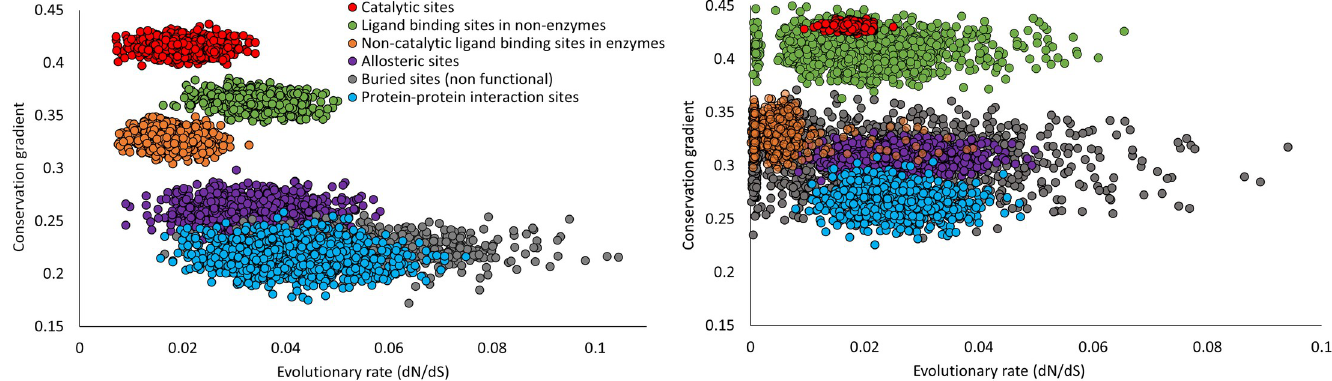
Fig 4. Catalytic site residues induce stronger conservation gradients than non-catalytic functional site residues with similar evolutionary rates. (A) Average conservation gradients of subsets of functional sites residues. (B) Average conservation gradients of subsets of the three most conserved residues within each functional site. Each circle represents a subset of residues, colored by different types of functional